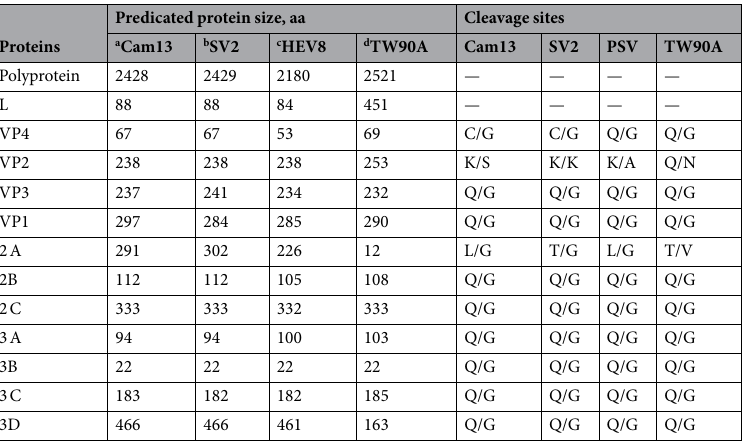
Table 1. Comparison of proteins and cleavage sites of sapeloviruses and avian anativirus TW90A. a LC503602,